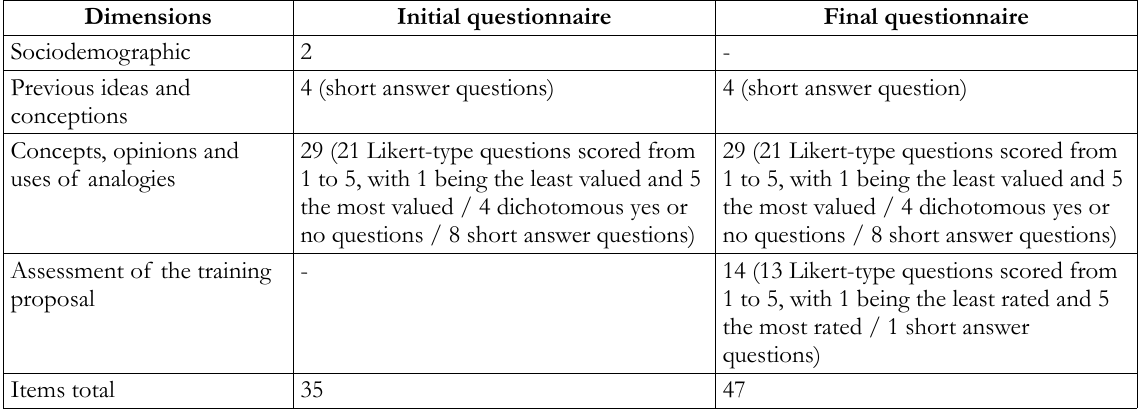
Table 5. Structure of the questionnaires